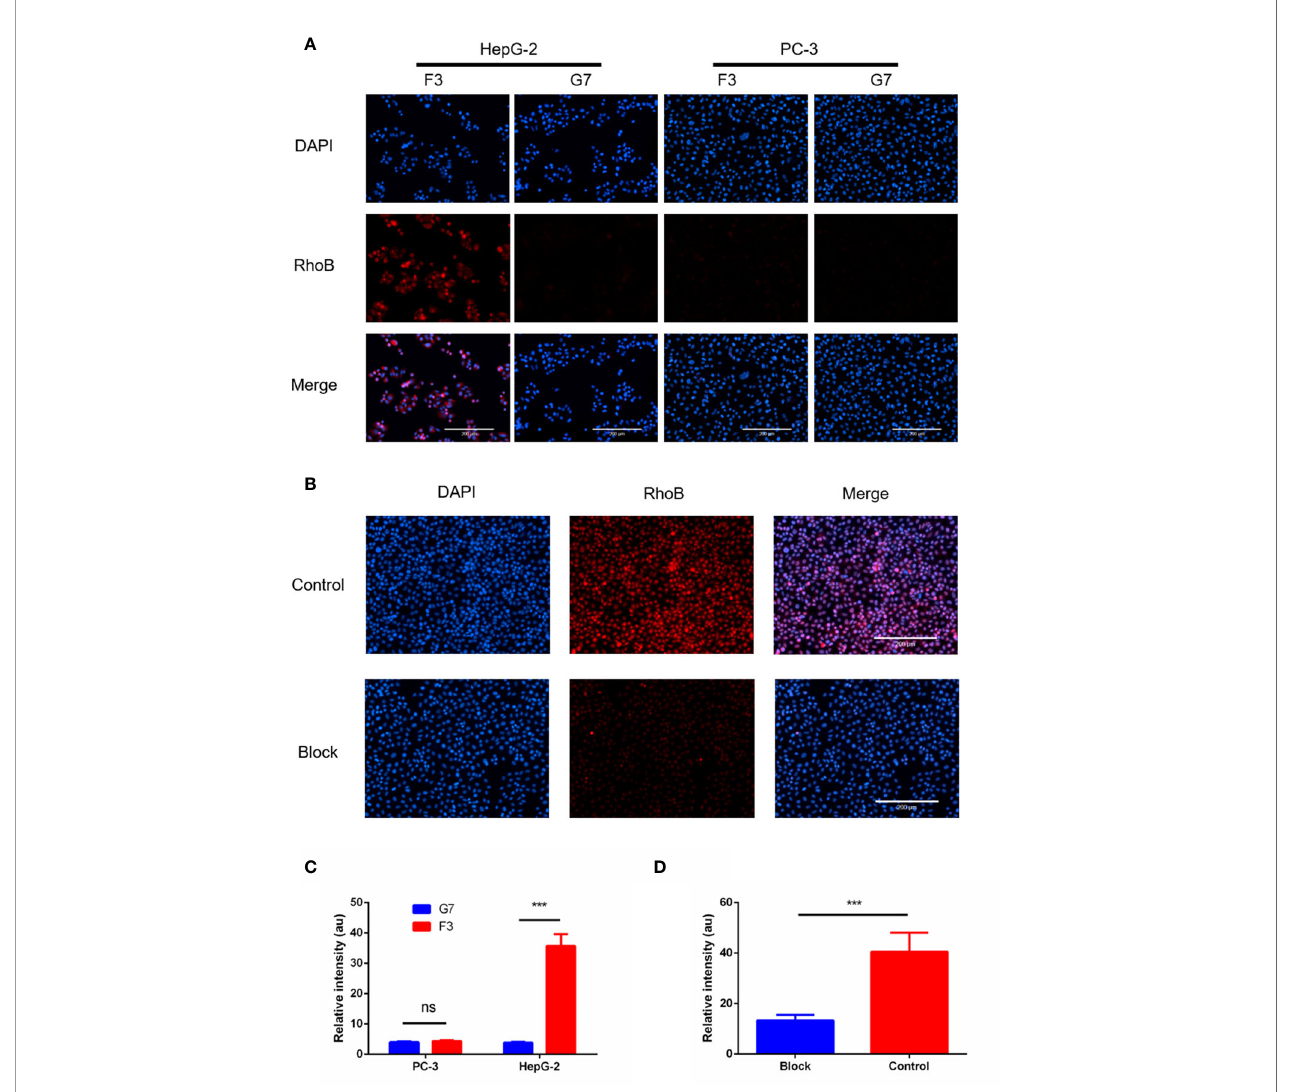
FIGURE 3 | RhoB-F3 peptide targeting of GPC-3 (+) cell lines in vitro . (A) Fluorescent cell staining in the HepG-2 and PC-3 cell lines using the RhoB-conjugated F3 peptide. Speci fi c binding of RhoB-F3 to HepG-2 cells could be observed as red fl uorescence. Nuclei were stained with DAPI (blue). Scale bars: 200 µm. (B) The RhoB-F3 binding to HepG-2 cells could be blocked by the pre-incubated anti-GPC-3 primary antibody compared to the control group without being blocked. Nuclei were stained with DAPI (blue). Scale bars: 200 µm. (C) Quanti fi cation of RhoB fl uorescence using the Image J in cell binding assay. F3 and G7 showed similar fl uorescence intensity in PC-3 cells (n = 5, p = 0.0767, ns, not statistically signi fi cant, two-tailed Student ’ s t-test). The RhoB-F3 binding to the HepG-2 cells was much stronger than RhoB-G7 (n = 5 per group, p = 0.0001, ***p < 0.001, two-tailed Student ’ s t-test). (D) Quanti fi cation of RhoB fl uorescence using Image J in the cell blocking assay. The binding activity between RhoB-F3 and HepG-2 cells could be effectively reduced by unlabeled F3 peptide (n = 5 per group, p = 0.0008, ***p < 0.001, two-tailed Student ’ s t-test). All data represent the means ± standard error. P-value was calculated by two-tailed Student ’ s